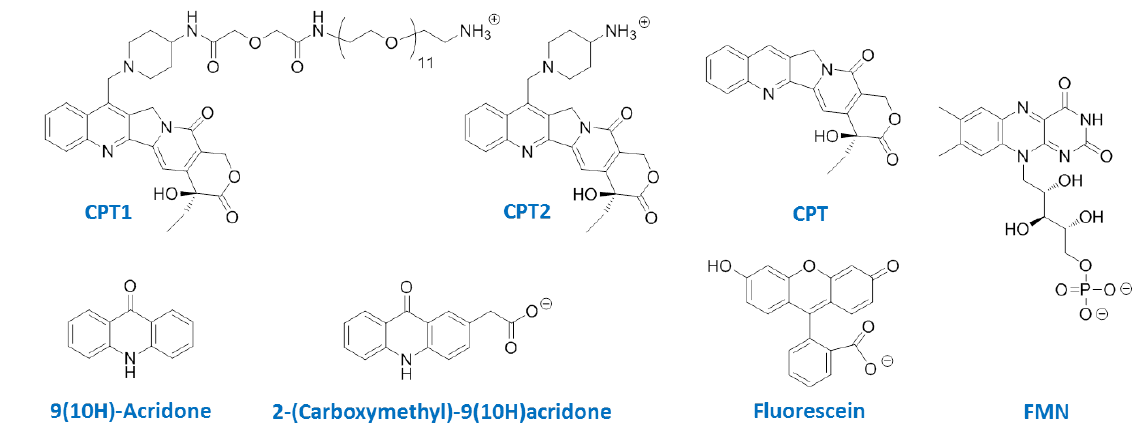
Figure 1. Chemical structures of analytes used in this